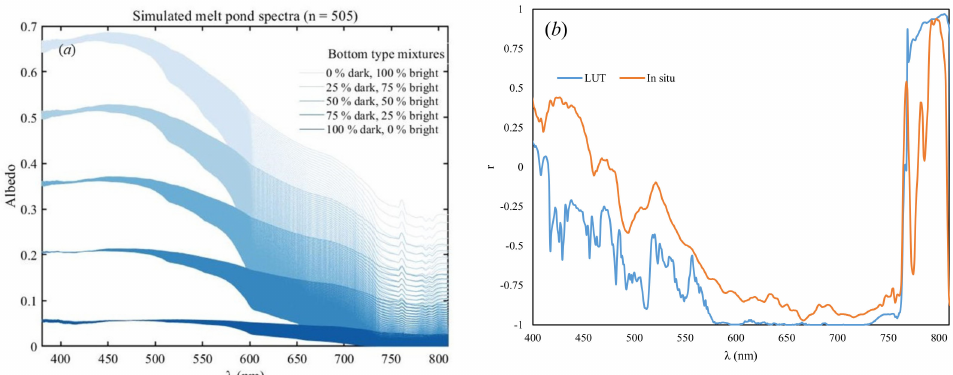
Figure 1. Panel ( a ) is the LUT generated with WASI, which contains 505 spectral and five different bottom types (100% dark, 0% bright; 75% dark, 25% bright; 50% dark, 50% bright; 25% dark, 75% bright; 0% dark, 100% bright). Panel ( b ) is that wavelength-dependent correlation of pond depth and the slope of the log-scaled spectral for LUT and in situ measurements.